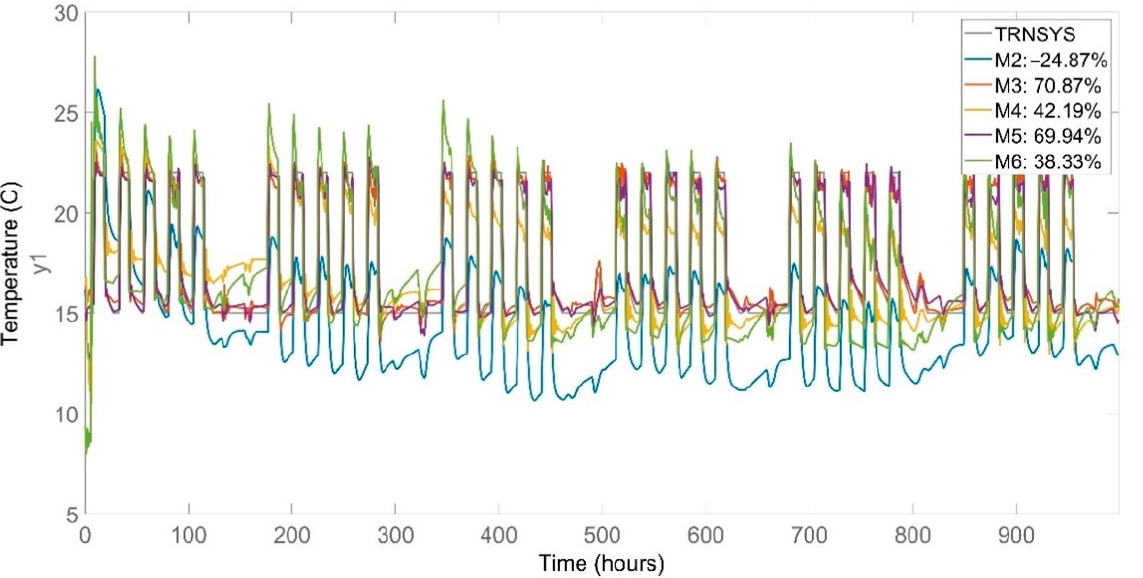
Figure 10. Comparison between identified models and the building simulated by TRNSYS. Table 1. Goodness of fit and MSE for each identified model compared to TRNSYS training dataset.